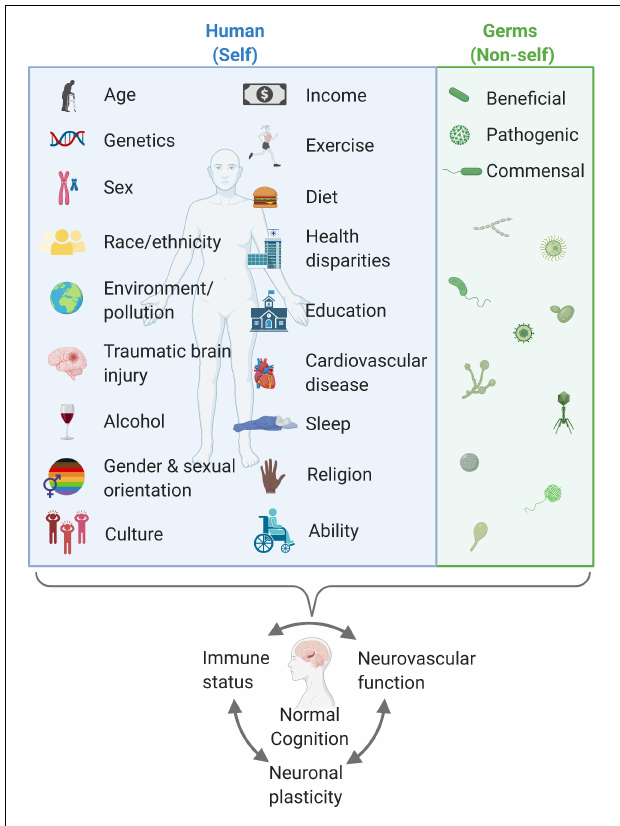
FIGURE 2 | Humans are complex, variable organisms who sum up to have differential neurovascular function, immune status, and neuronal plasticity that impacts cognitive status (blue box). Furthermore, beneficial, pathogenic, and commensal germs also play a pivotal role. There are modifiable behaviors that may help in maintaining and promoting healthy cognition. A healthy balance of both self and non-self is key for a healthy body and mind. Created with